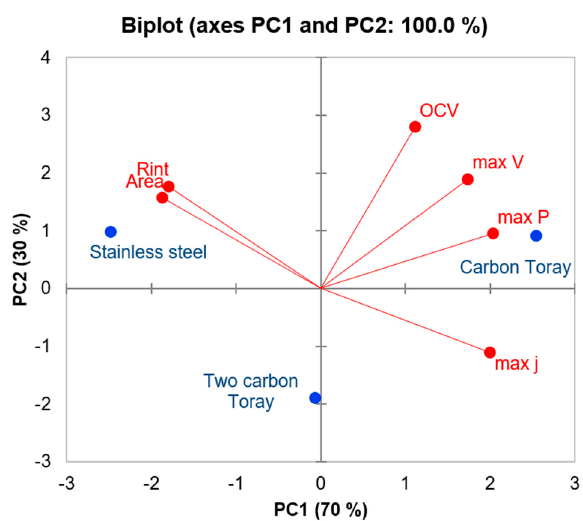
Figure 7. Principle component analysis (PCA) biplots of bioelectrochemical parameters.